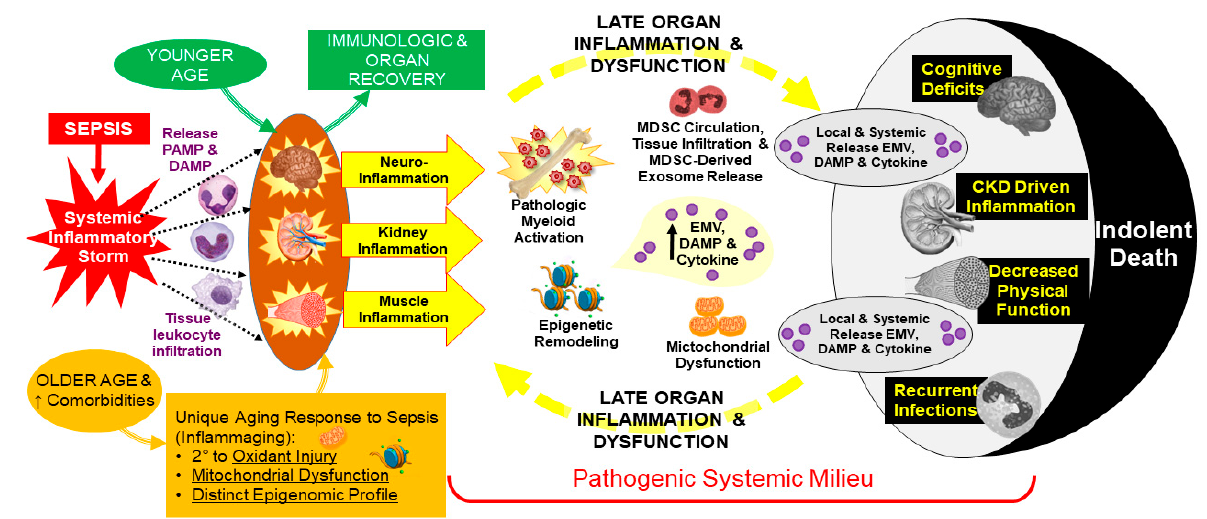
Figure 2. Pathophysiology of Chronic Critical Illness (CCI) and Persistent Inflammation, Immunosuppression, and Catabolism Syndrome (PICS). Abbreviations: DAMP—damage-associated molecular protein, EMV—exosome and microvesicle.